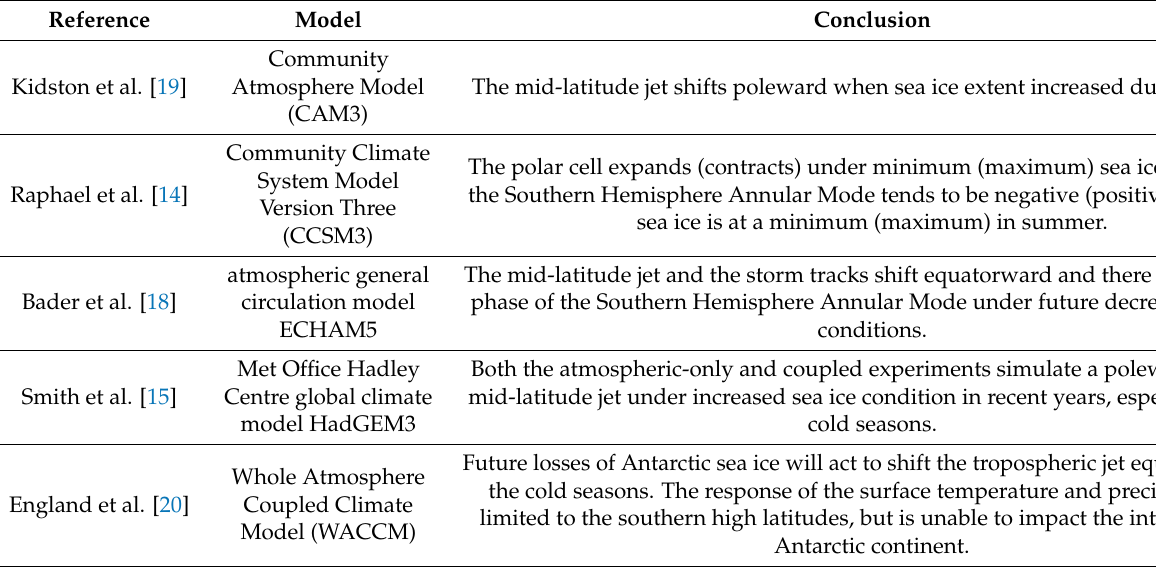
Table 1. Previous studies that have explored the impacts of Antarctic sea ice changes on the Southern Hemisphere.